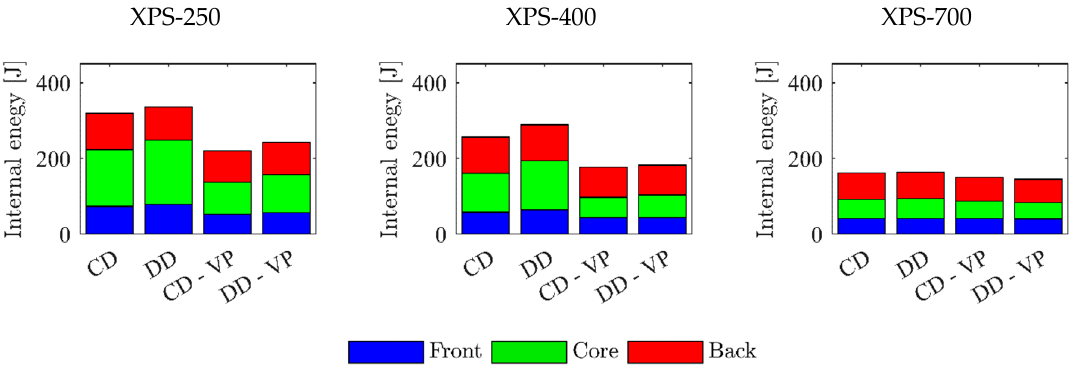
Figure A7. Distribution of internal energy in the numerical models of tests with 12 bar firing pressure.